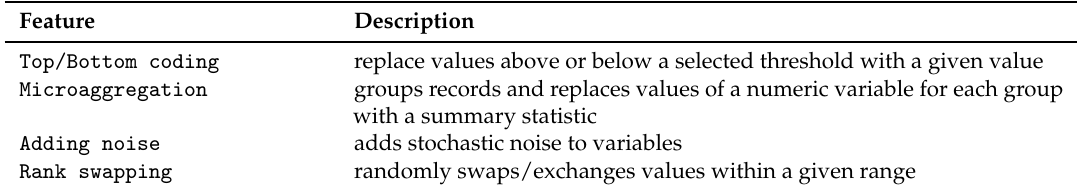
Table 6. Anonymization methods for continuous